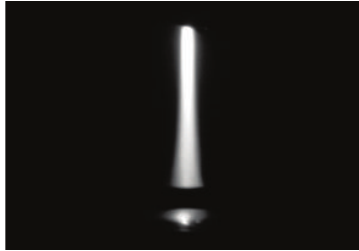
Figure 8: Plasma arc in no magnetic